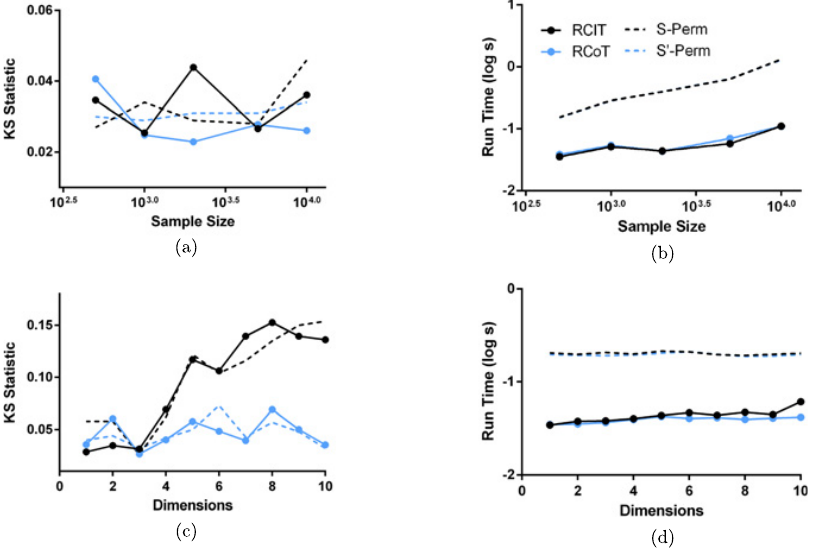
Figure 6: Results of the same KS statistic experiments as in Section 7.2 except comparing RCIT and RCoT against S-Perm and S 󸀠 -Perm. Subfigures (a) and (b) again vary as a function of sample size, while subfigures (c) and (d) vary as a function of condi- tioning set size. RCIT and RCoT are faster than the permutation tests but yield comparable average KS statistic